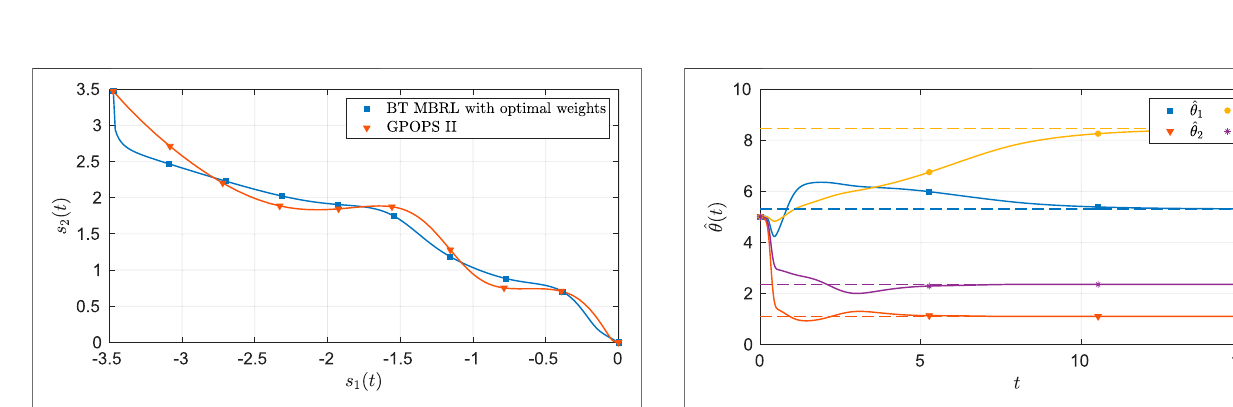
FIGURE 8 | Estimates of the unknown parameters in the system under the nominal gains for the four-state dynamical system. The dash lines in the fi gure indicates the ideal values of the